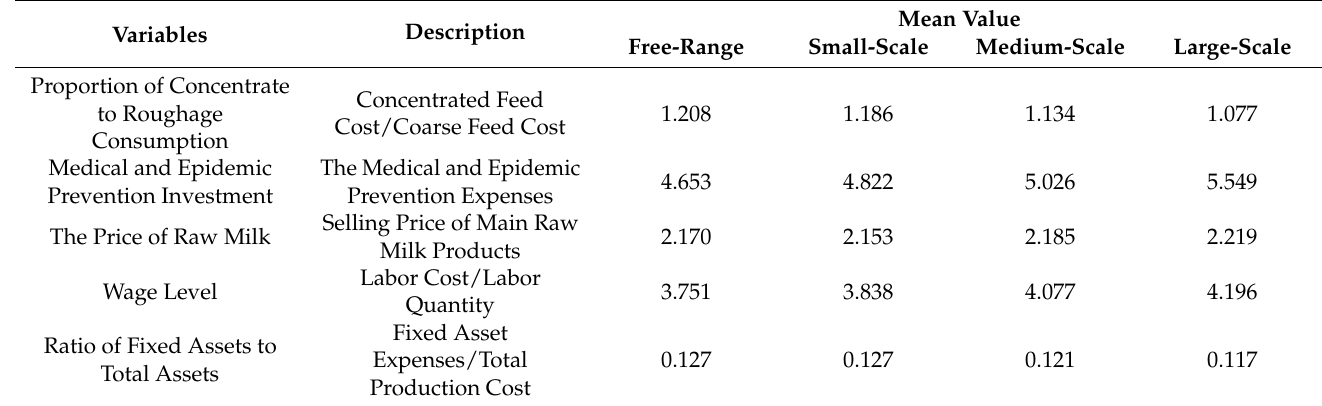
Table 6. Description and statistics of influencing factor variables.